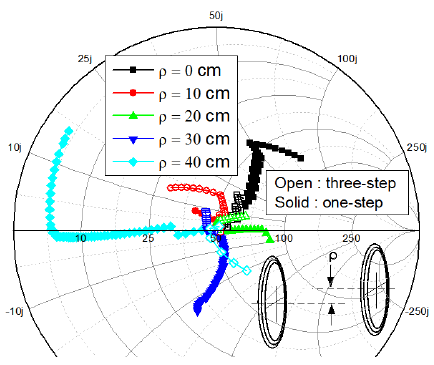
Figure 14. Trajectory of the measured input impedance for different misalignments from ρ = 0 cm to 40 cm for d = 15 cm.